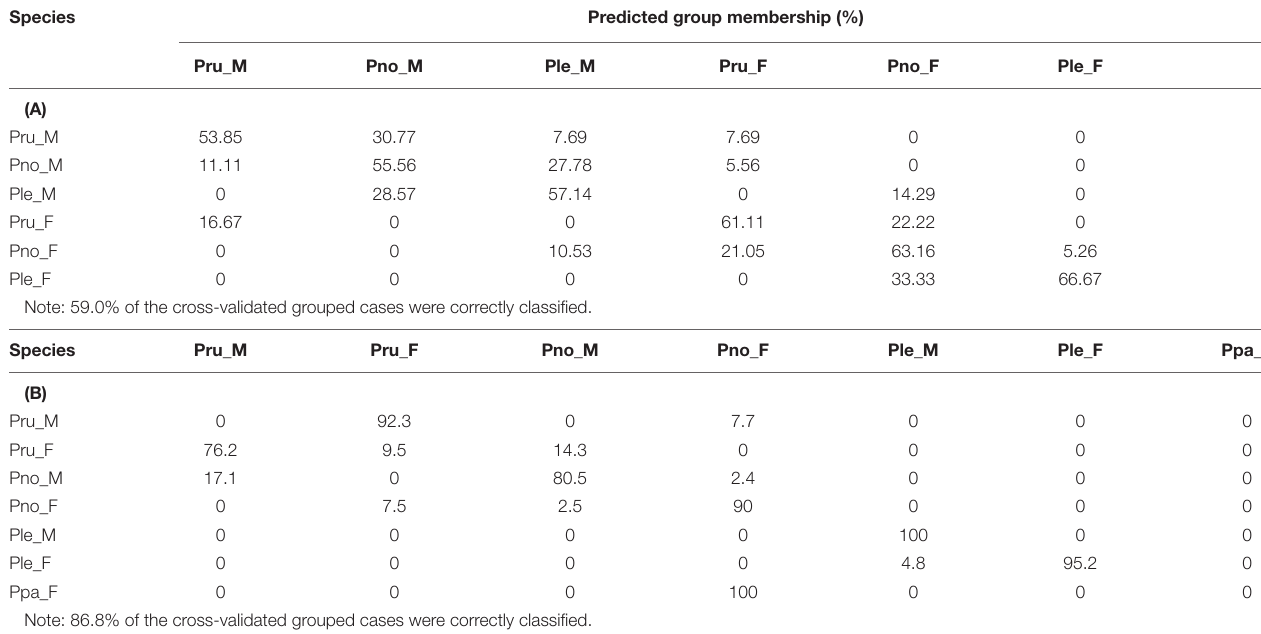
TABLE 1 | Percent values of the cross-validated discriminant analysis, based on the principal component (PC) scores of: (A) Scapulocoracoid linear morphometric measurements, (B) Body linear morphometric. Group codes are: Pru = Psammobatis rudis , Pno = P. normani , Ple = P. lentiginosa , Ppa = P. parvacauda , M = males, F =